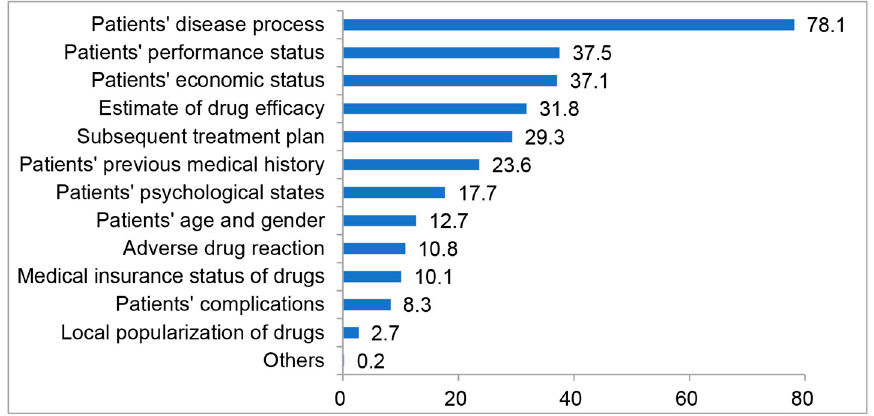
Figure 2. The average score based on the considerations of 495 doctors making treatment plans for HER2-positive metastatic breast cancer patients. (It is a ranking question requiring selection of 5 options, which are rated as 100, 80, 60, 40, 20 scores and 0 score for those are not selected).